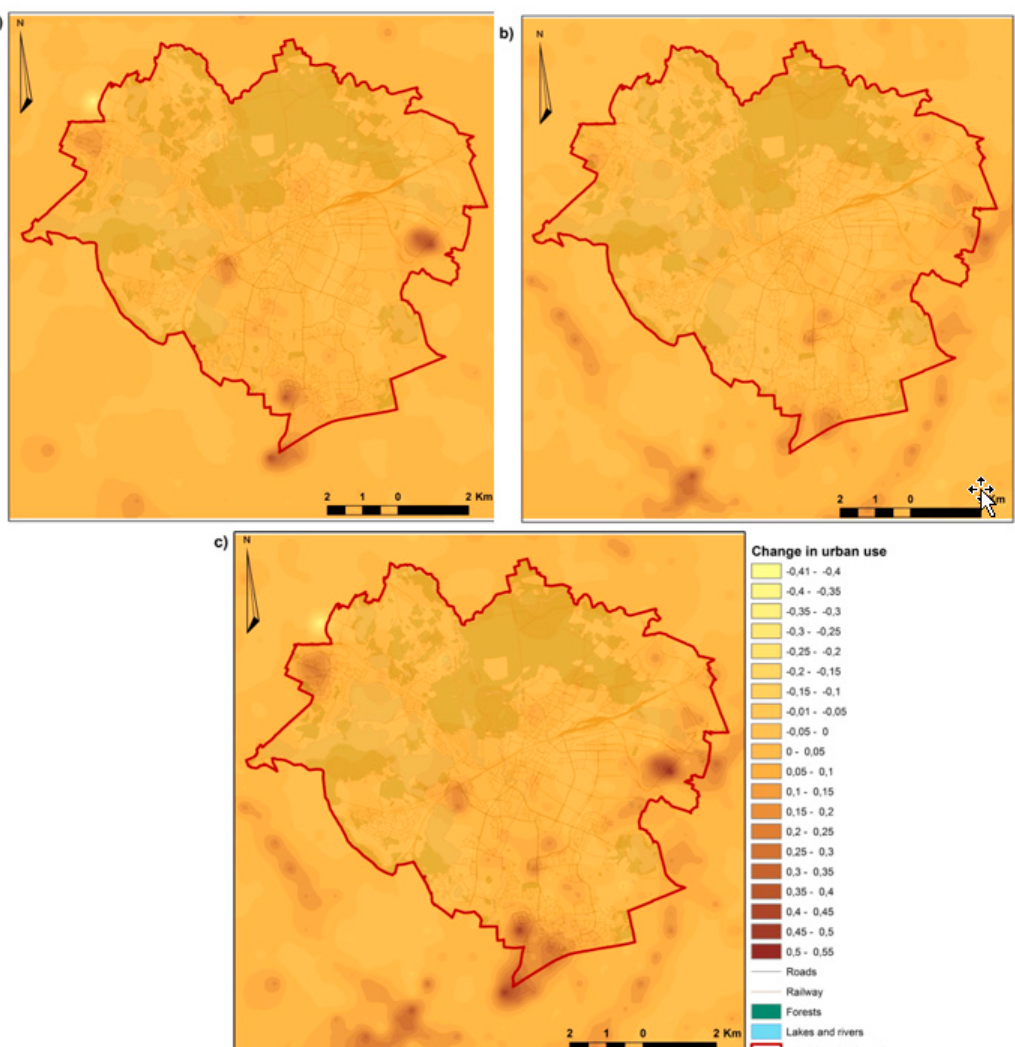
Figure 6. Changes in land use: ( a ): 2005–2010; ( b ): 2010–2017; ( c ): 2005–2017.